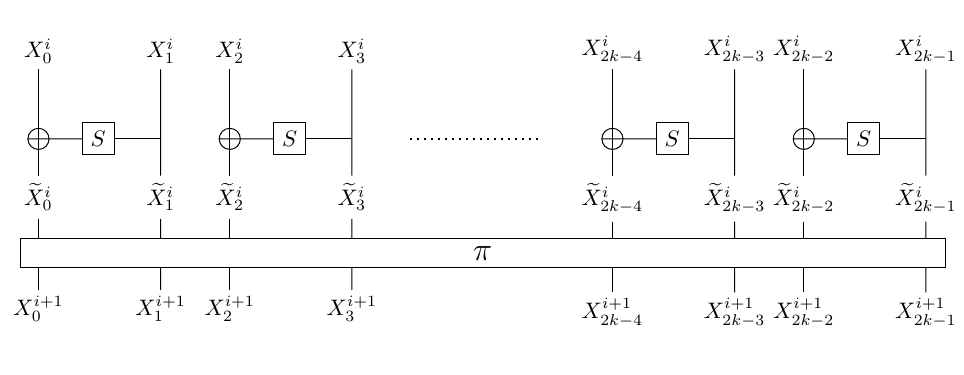
Figure 1: Generalized Feistel